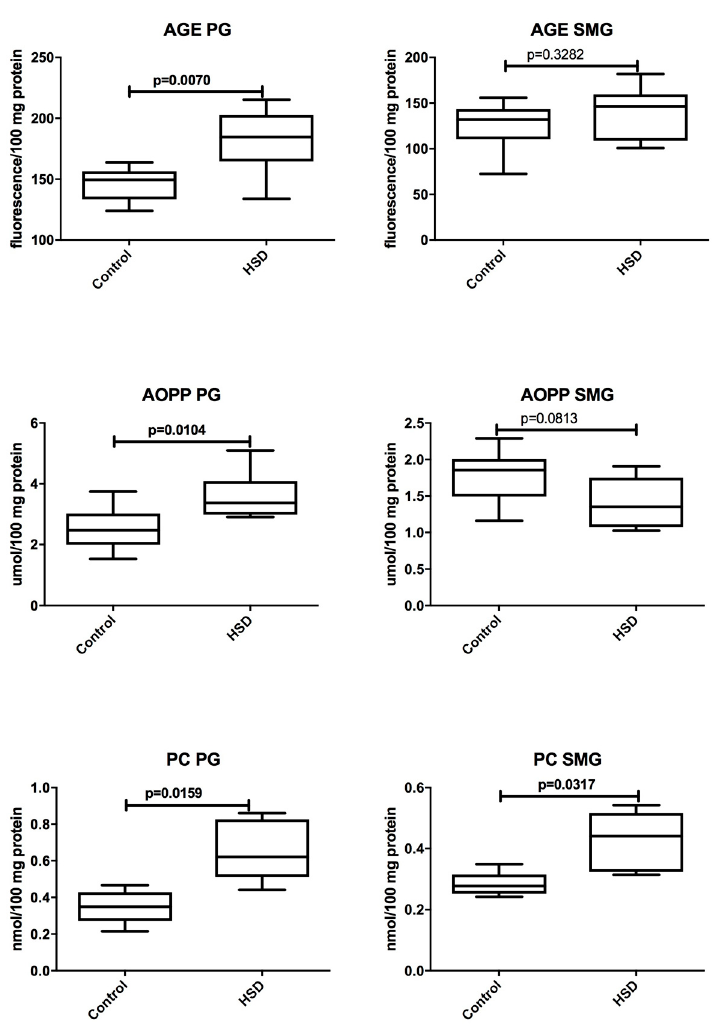
Figure 6. The effect of a high-sucrose diet (HSD) on protein oxidative damage. Abbreviations: AGE, advanced glycation end products, AOPP, advanced oxidation protein products, PC, protein carbonyls, PG, parotid glands, SMG, submandibular